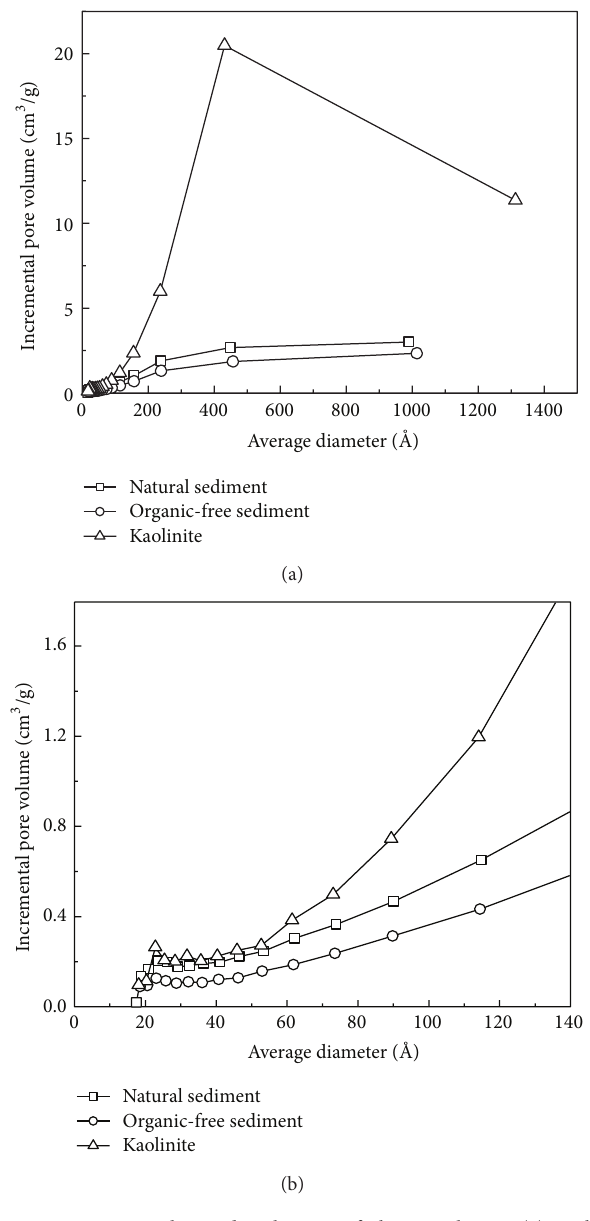
Figure 1: Pore volume distribution of three sorbents: (a) with average diameter ranging in 0–1400 ˚A; (b) with average diameter ranging in 0–140 ˚A.